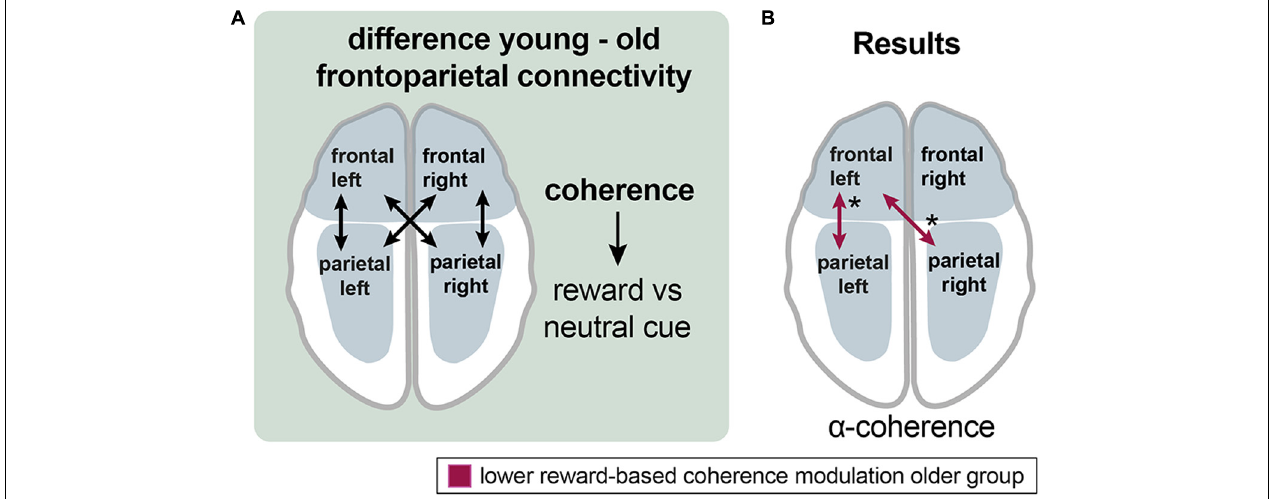
FIGURE 6 | Aging effects on the frontoparietal control network during reward processing . (A) Analyzing the procedure scheme: group differences in coherence between frontal and parietal channel groups were assessed for the reward vs. neutral cue contrast. (B) Results: Older adults exhibited lower reward-related frontoparietal left and frontal left-parietal right coherence modulation in the alpha band (red arrows). Asterisks: one asterisk: p ≤ 0.05.